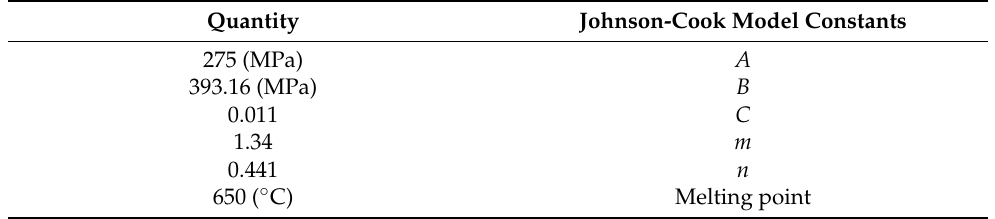
Table 2. Johnson–Cook model constants for AA 6061-T6 [26].